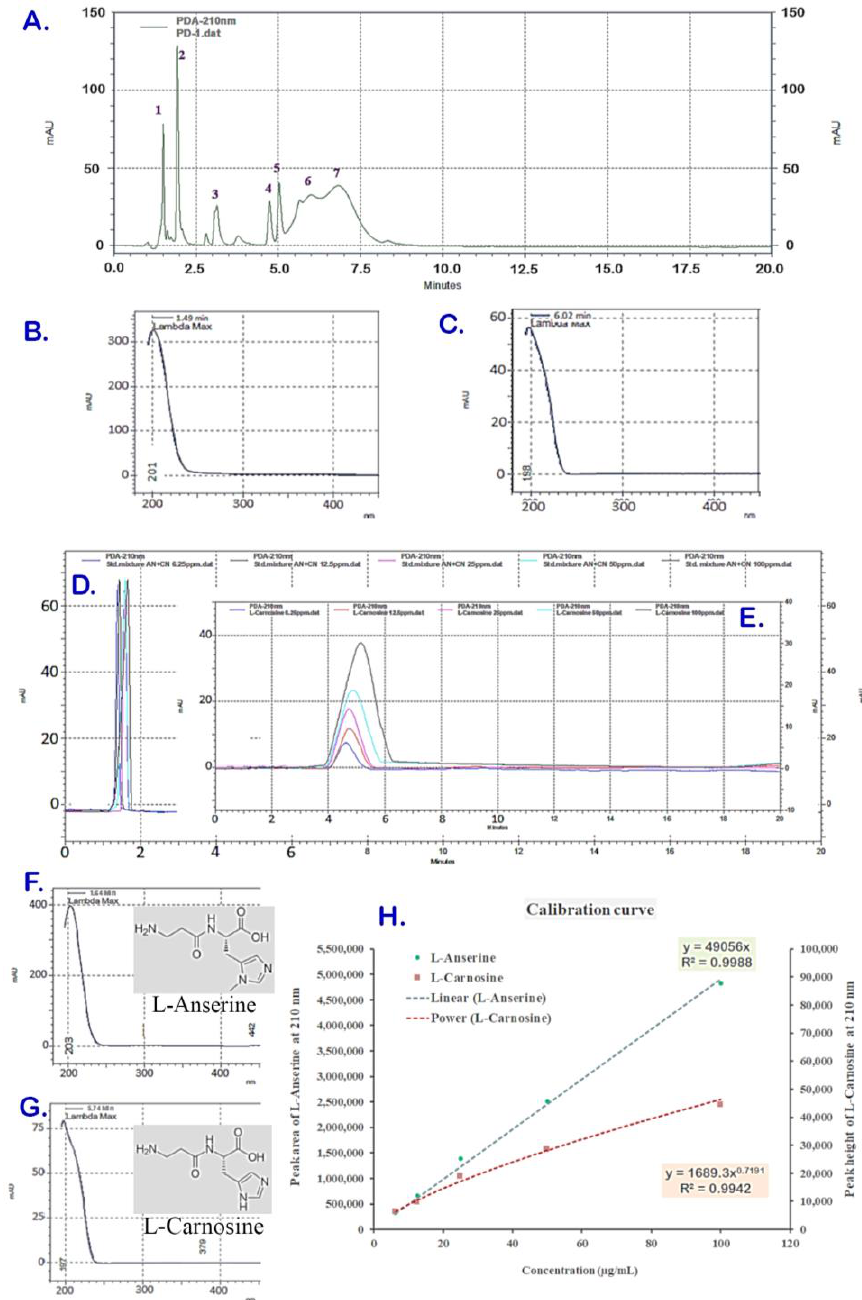
Figure 1. HPLC chromatogram of PD sample containing seven peaks ( A ). Peak #1 was at retention time (RT) 1.50 with a specific UV spectrum (λmax 196 nm) ( B ), and peak #6 was at RT 5.99 min with a particular UV spectrum (λmax 196 nm) ( C ), which were identified as L-anserine and L-carnosine when compared to the standard compounds. The reference standard L-anserine was eluted at RT 1.38 min ( D ) with UV spectrum (λmax 204 nm) ( F ). Meanwhile, L-carnosine was eluted at RT 5.77 min ( E ) with UV spectrum (λmax 199 nm) ( G ). The linear calibration curves of L-anserine plotted between peak areas versus corresponding concentrations and the polynomial calibration curve of L-carnosine plotted between peak heights versus corresponding concentrations ( H ) were established from the chromatograms of various concentrations ( D and E , respectively).